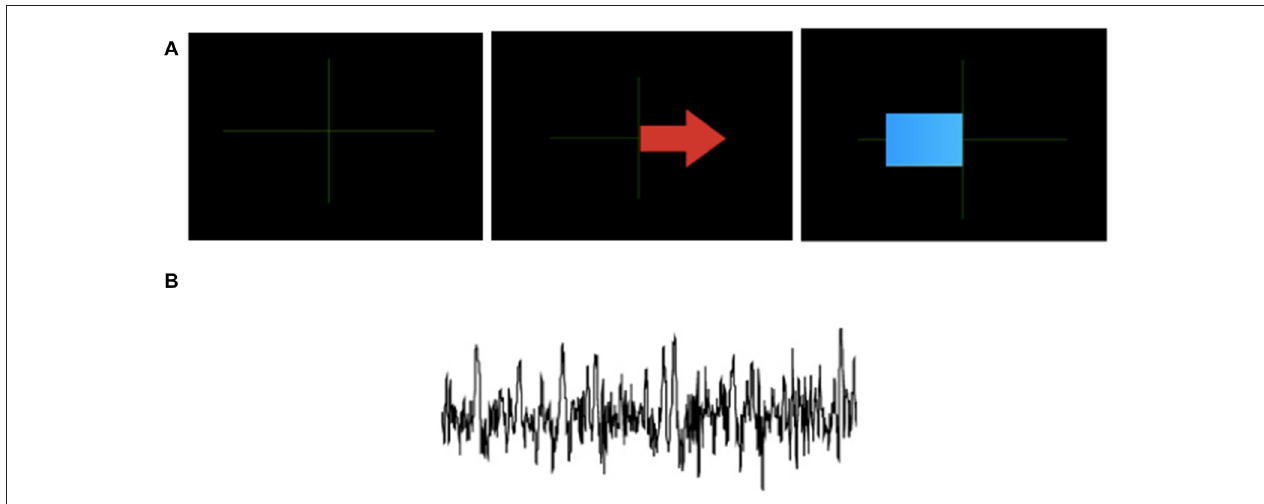
FIGURE 1 | Examples of feedback in traditional brain–computer interface (BCI) training protocols (TPs; usually for expert users). Figure is reproduced with permission from the copyright holder. (A) Classification feedback from GRAZ BCI protocol: an arrow pointing right indicates to the learner to imagine a right hand movement. The blue bar gives feedback with its direction and length based on the classifier output. Thus it shows how well the mental task is recognized. The bar extends towards the left for an imagined left hand movement, and toward the right for the imagined right hand movement (adapted from http://OpenViBE.inria.fr). (B) Brain signals where only relevant activity has been